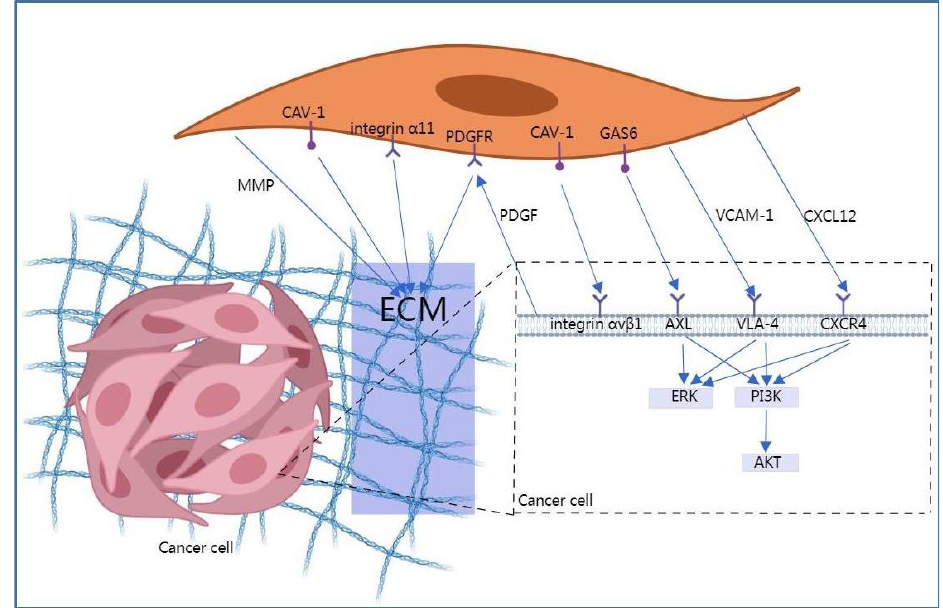
Figure 1. Cancer-associated fibroblasts (CAFs) mediate NSCLC metastasis and invasion . CAV-1, Caveolin-1; CXCL12, C-X-C motif chemokine ligand 12; ECM, extracellular matrix; GAS6, Growth arrest-specific 6; MMP, Matrix metalloproteinase; PDGF, Platelet-derived growth factor; PDGFR, Platelet-derived growth factor receptor; VCAM-1, Vascular cell adhesion molecule-1.